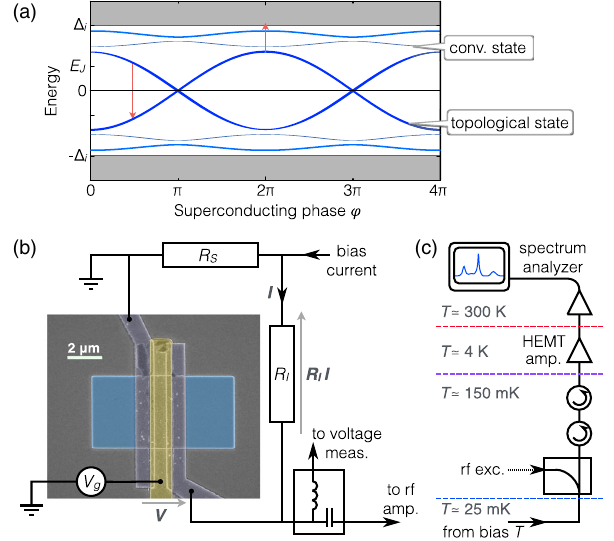
FIG. 1. Voltage bias and measurement setups. (a) The spectrum of Andreev bound states in a topological Josephson junction hosts a 4 π -periodic gapless Andreev doublet (dark blue) around zero energy, and other gapped Andreev modes (bulk or edge modes, depicted in light blue). Coupling to the continuum (gray area), other Andreev states, and possible relaxation mechanisms are pictured as red arrows. The exact spectrum is not known, and depends on parameters such as length of the junction and Fermi energy. (b) On the colored SEM picture, the mesa is visible in blue, the Al leads in violet, and the gate is indicated in yellow. A shunt resistance R enables a stable voltage bias across the junction. The S measurement of the voltage across the junction and across R I directly yields V and I . The rf signal is coupled to the amplification scheme via a bias T . (c) The rf signal is amplified by a cryogenic HEMT amplifier (with additional room-temperature amplifica- tion). A directional coupler can be used to send a rf excitation signal (backwards) for characterization purposes (see SM